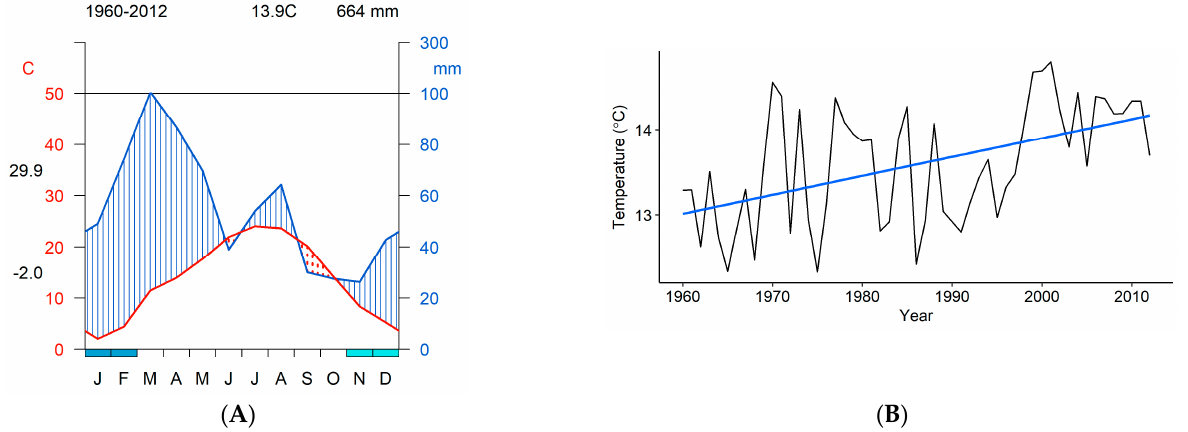
Figure 2. ( A ) Monthly climate diagram of Srinagar based on instrumental data from Srinagar meteorological station. ( B ) The long ‐ term mean annual temperature of Srinagar (1960–2012).